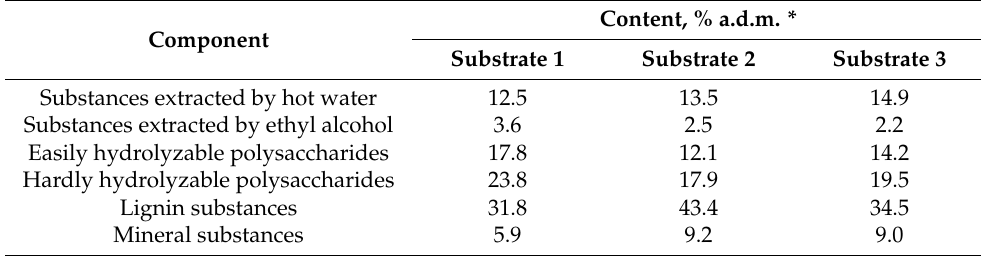
Table 1. Componential composition of the substrates prior to biodestruction. Content, % a.d.m. * Component Substrate 1 Substrate 2 Substances extracted by hot